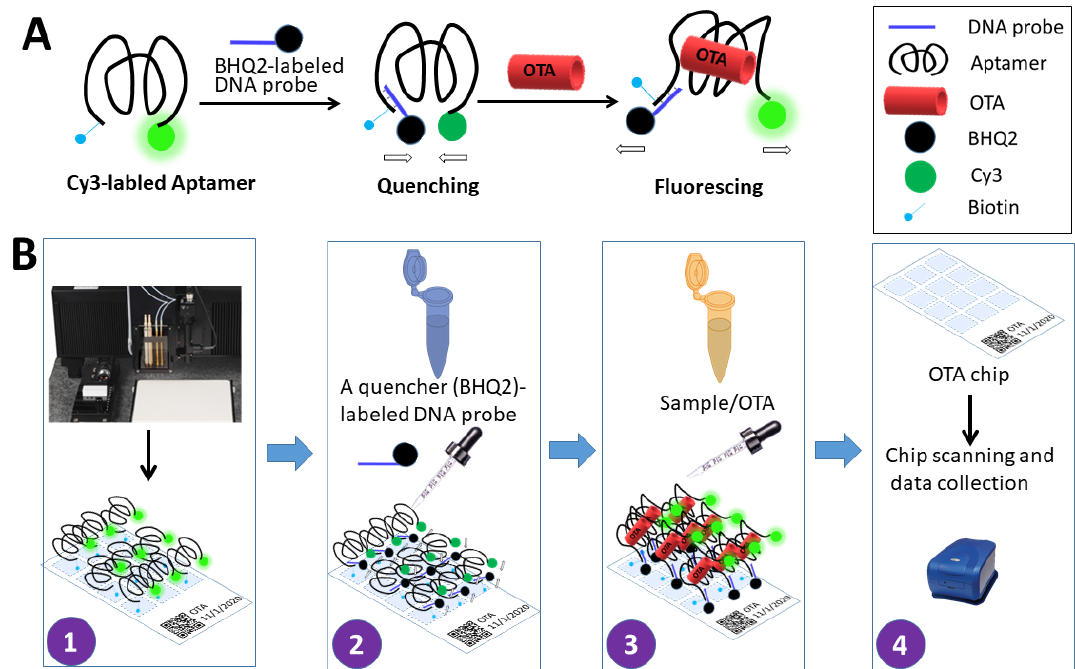
Figure 1. Detection of ochratoxin A on an aptamer-based chip via fluorescence resonance energy transfer. When bound by a BHQ2-labeled oligonucleotide complementary to the OTA-specific aptamer sequence, the fluorescence of the Cy3-labeled OTA aptamer was quenched via fluorescence resonance energy transfer (FRET). The subsequent OTA binding to the aptamer caused the separation of the fluorophore Cy3 from the quencher BHQ2, which led to the generation of fluorescence signals ( A ). This detection system could be built on a chip and the signal can be analyzed using a fluorescence scanner ( B ). (1) Printing Cy3-labeled OTA aptamer on the chip; (2) Adding a quencher (BHQ2)-labled DNA probe onto the